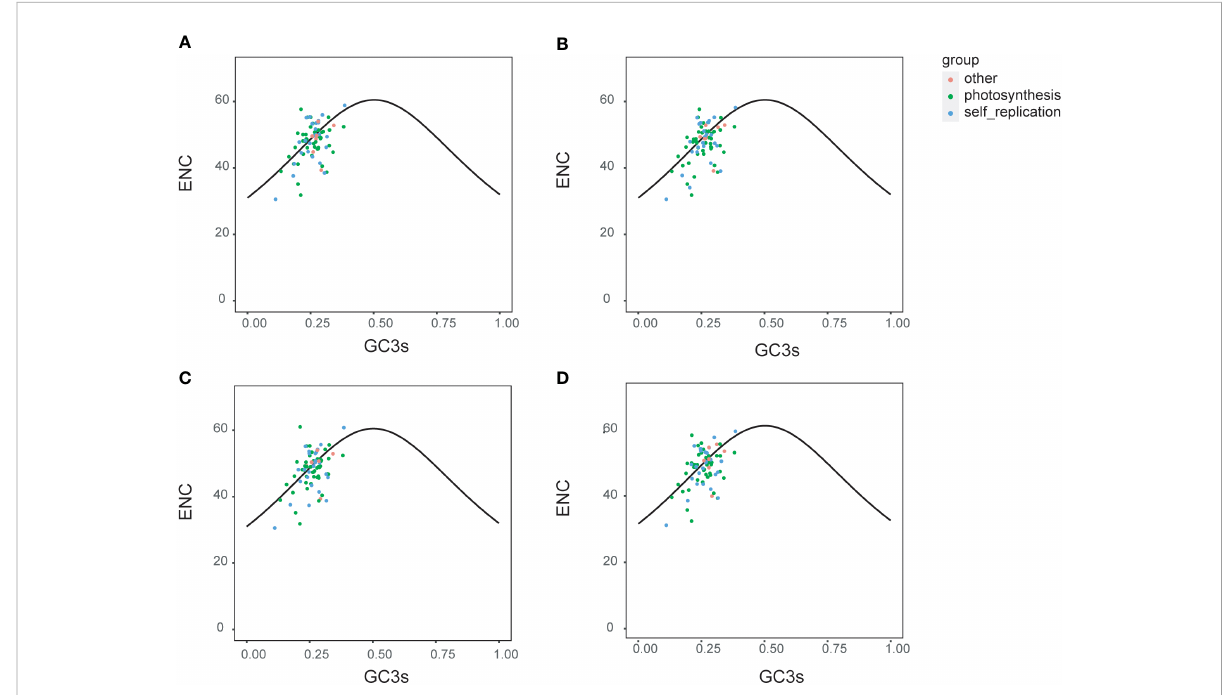
FIGURE 3 Enc plotted against GC3s of three Ipomoea species. The solid lines represented the expected curve of positions of genes when the codon usage was only determined by the GC3s composition. Enc and GC3s plots for four Ipomoea species, including I pes-caprae (A) , I involucrate (B) , I murucoides (C) , and I tricolor (D) .